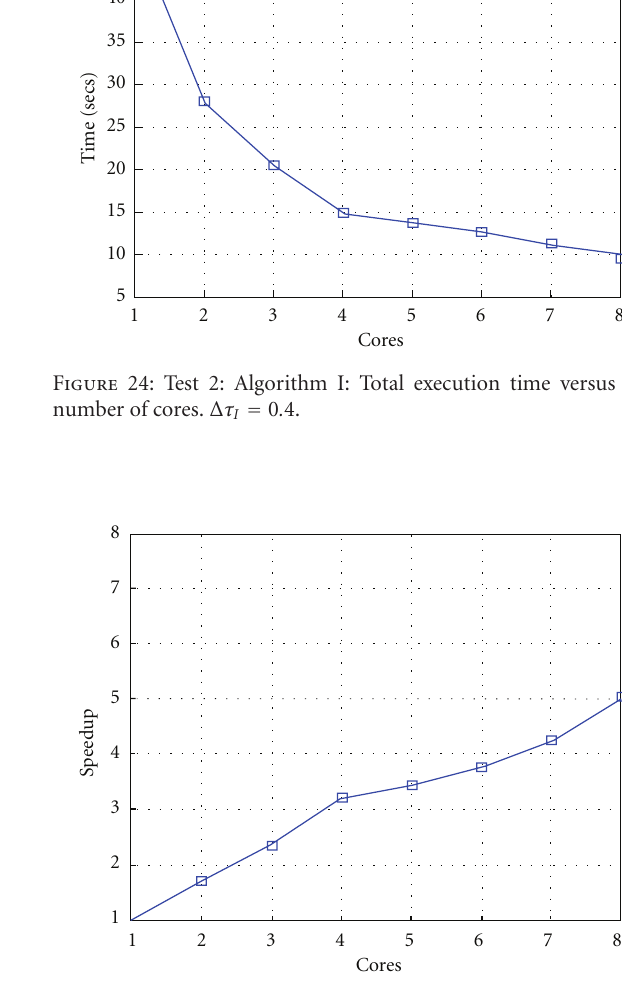
Figure 25: Test 2: Algorithm I. Speed up. Δ τ I = 0 . 4.